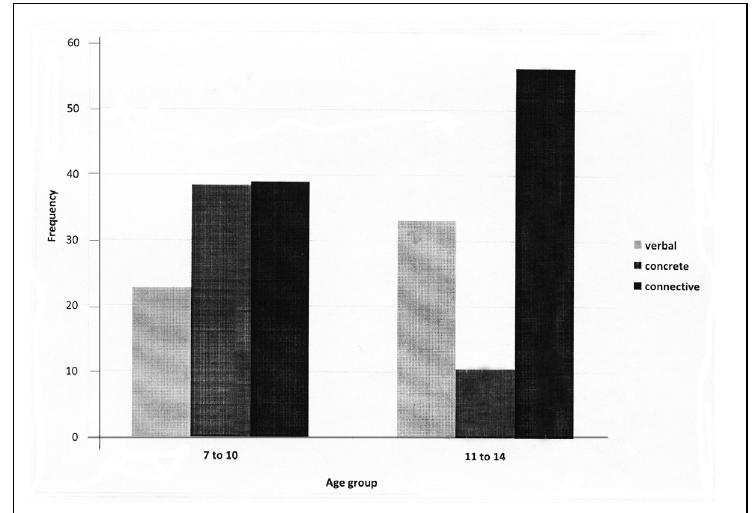
Figure 2 . Percentage, by age group, of the most developed types of